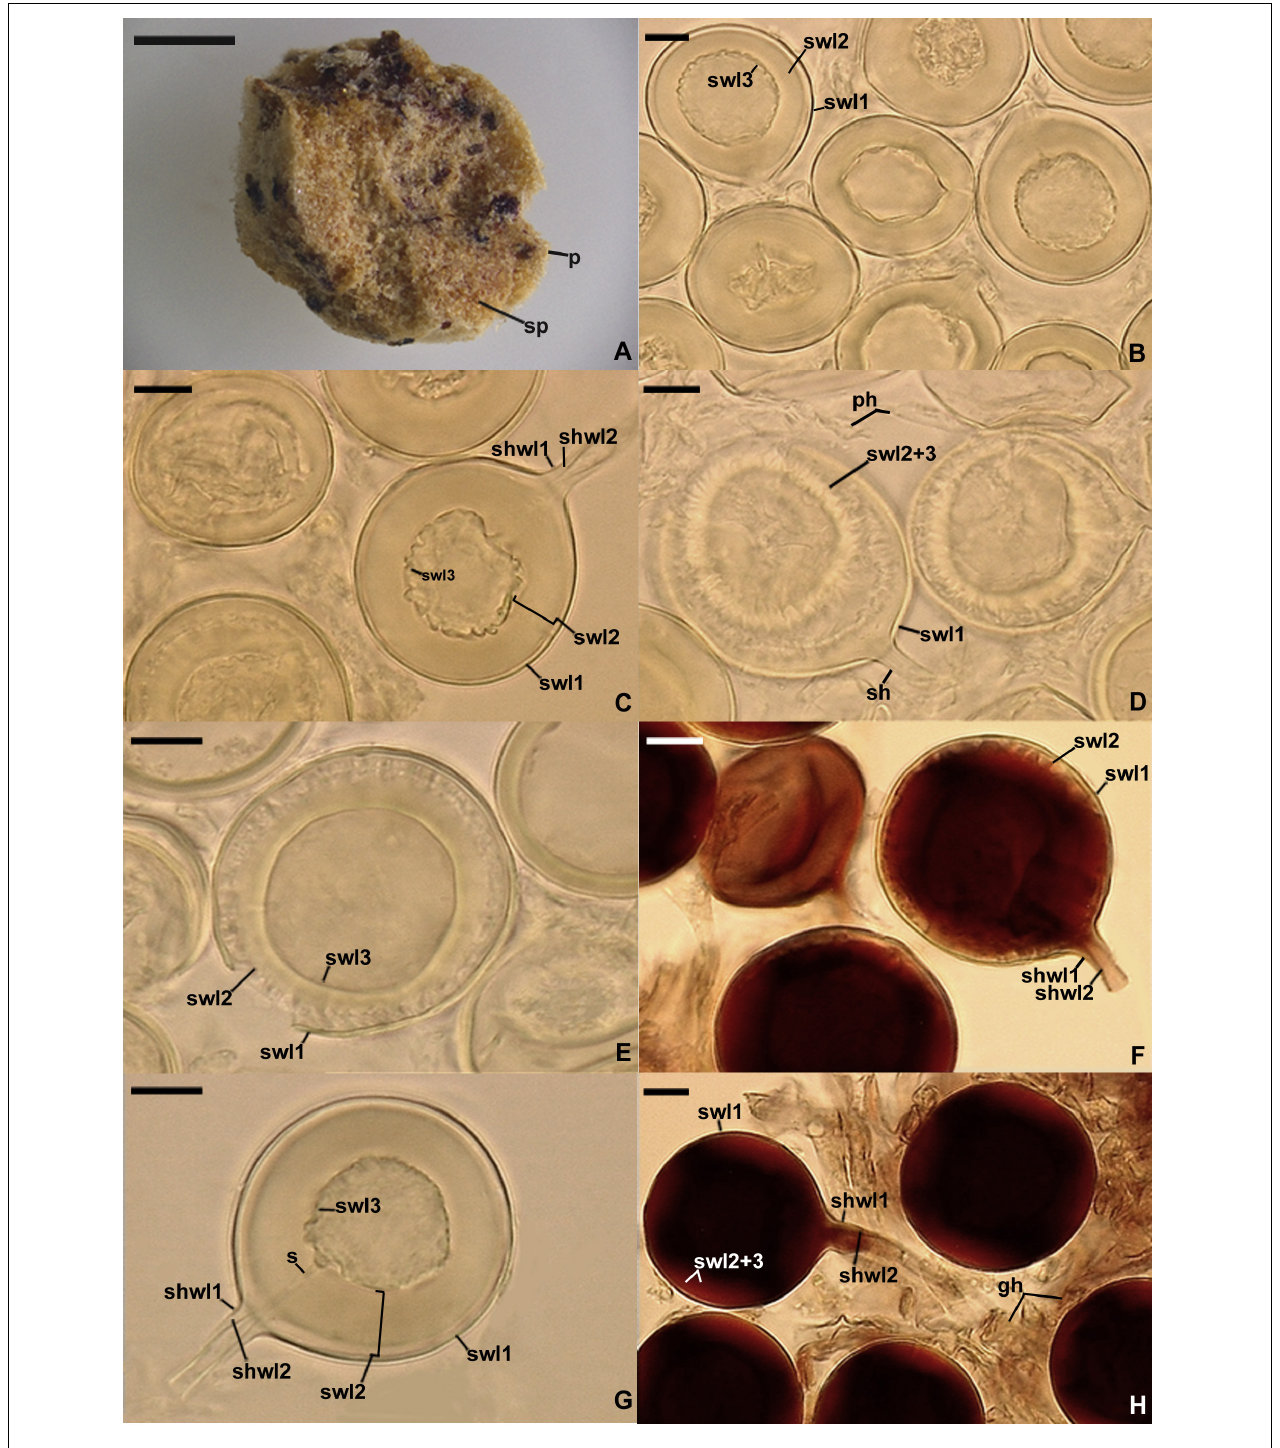
FIGURE 5 | Epigeocarpum crypticum . (A) Glomerocarp (=sporocarp) with glomerospores (=spores; sp). (B) Spores on which no pressure was applied; note that spore wall layer (swl) 2 slightly contracted and separated from the lower surface of swl1, and swl3 only slightly separated from the lower surface of swl2. (C–G) Spore wall layers (swl) 1–3 and subtending hyphal wall layers (shwl) 1 and 2 of spores on which pressure was applied; note that the laminate swl2 transferred into a crown-like structure, and swl3 usually slightly contracted and separated from the lower surface of swl2 and formed a septum (s) located at approximately half the length of the channel connecting the subtending hyphal lumen with the spore interior; peridial hyphae (ph) are visible in (D) . (H) Intact spores with swl1–3, shwl1 and 2, and glebal hyphae (gh) mounted in PVLG + Melzer’s reagent. (A) Dry specimen. (B–E,G) Spores in PVLG. (F,H) Spores in PVLG + Melzer’s reagent. (A) Light microscopy. (B–H) Differential interference microscopy. Scale bars: (A) = 200 µ m, (B–H) = 10 µ m.